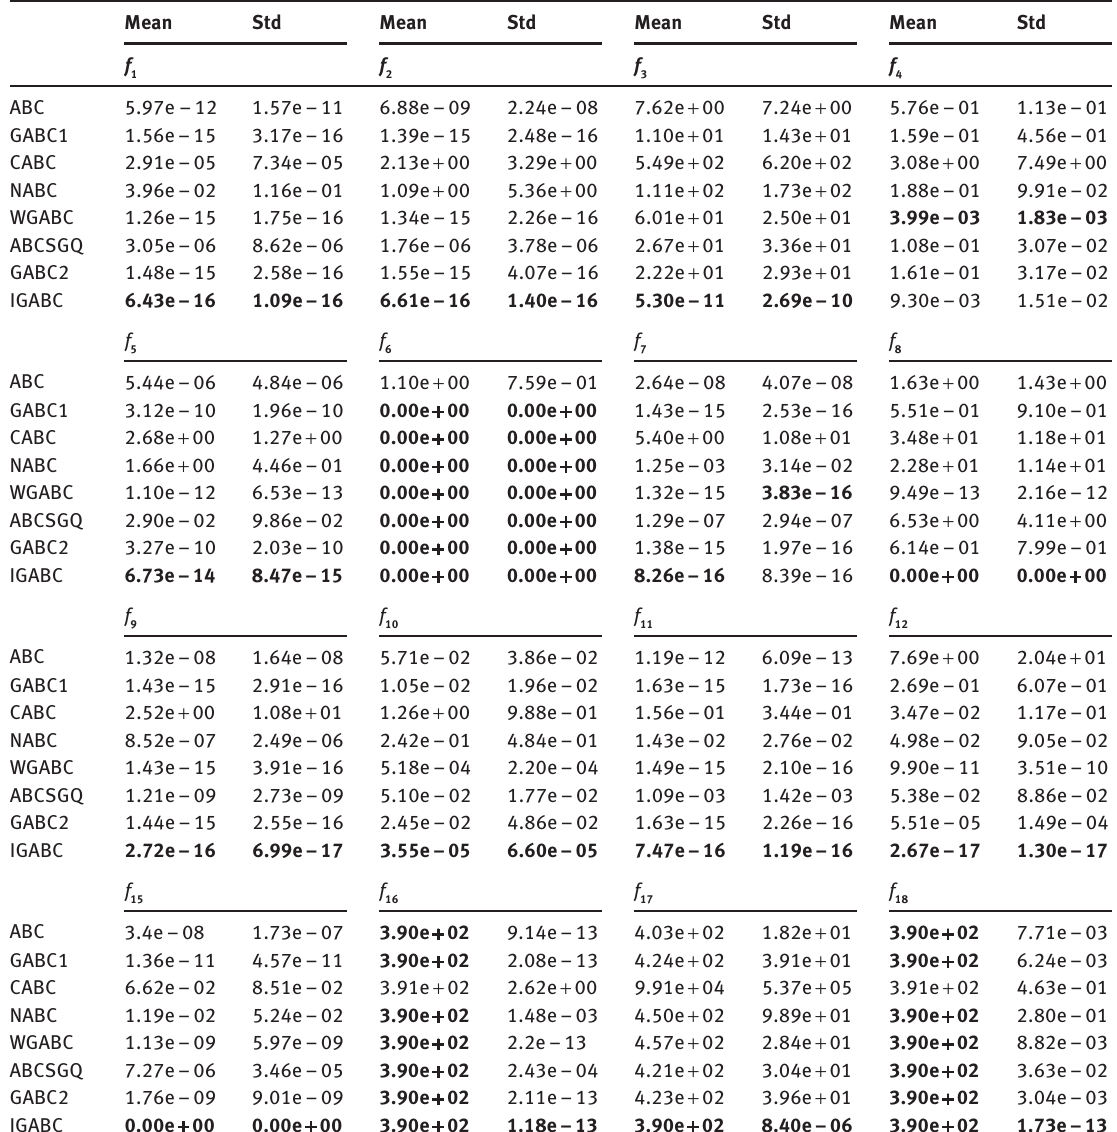
Table 3: Comparison of the Test Results of Eight Algorithms ( D =